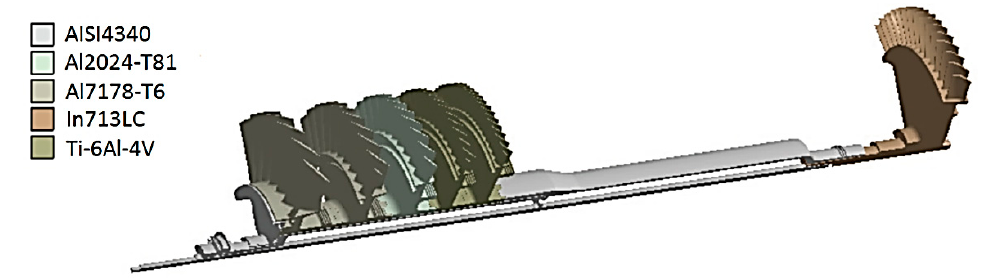
Figure 3. A one eighth section of the rotating assembly showing the chosen metallic alloys for each component.